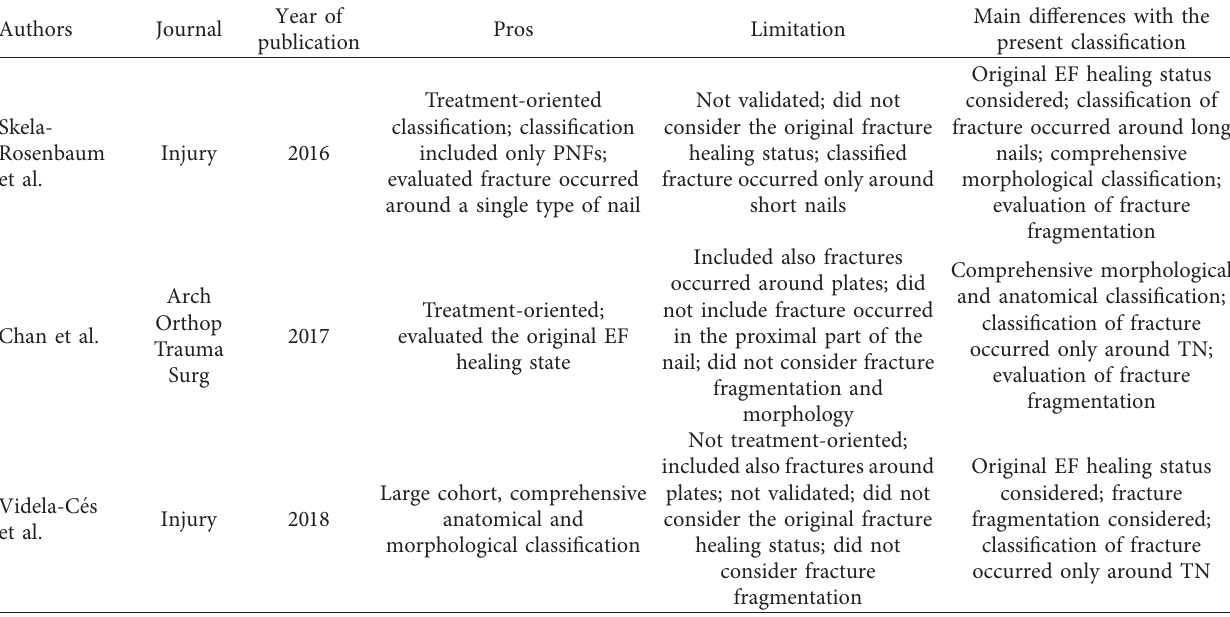
Table 3: Published peri-implant femoral fracture